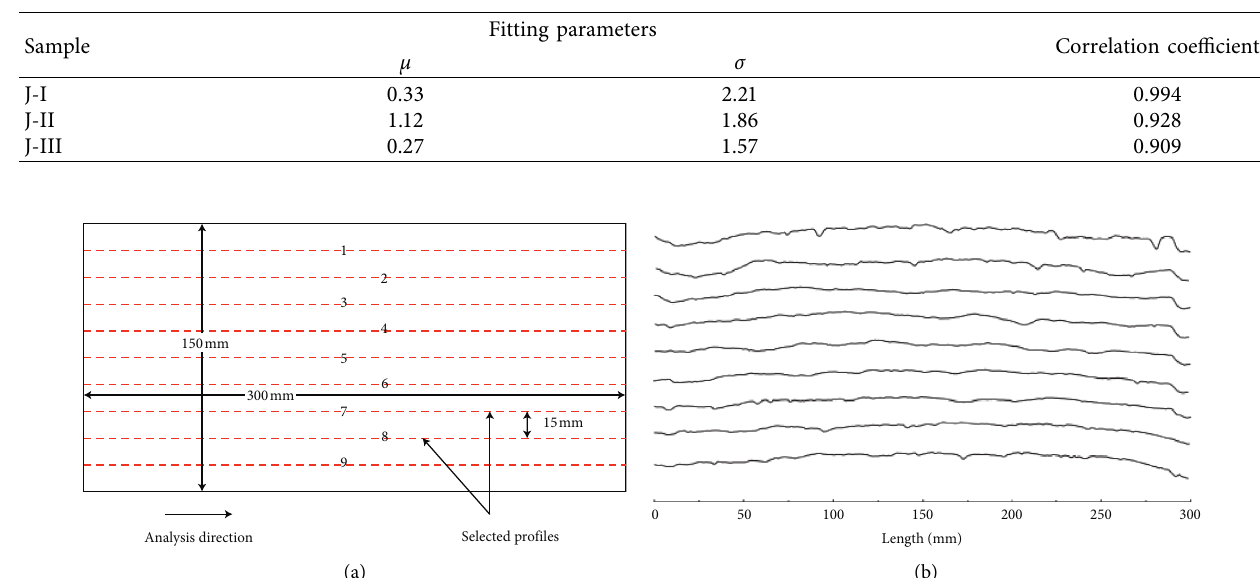
Figure 2: Method to select joint profiles. (a) Position of joint profiles for morphology analysis. (b) Selected joint profiles (J-II is taken as an example).